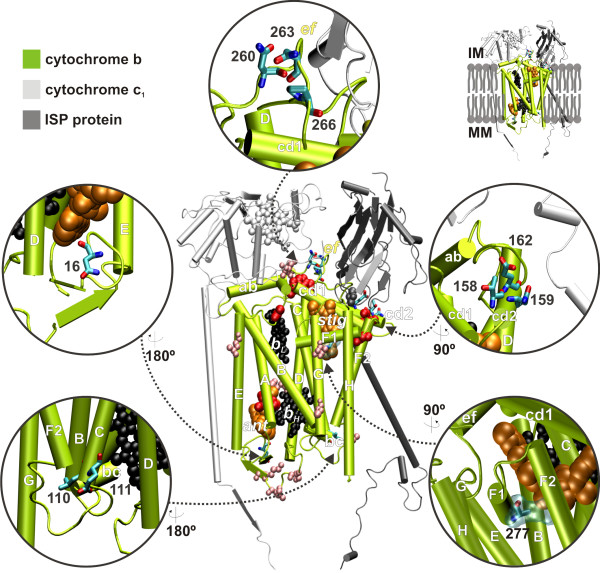
Three-dimensional representation of relevant variable amino acids in mammalian cytochrome b. Illustrative representation of some of the amino acid variable sites (see Figure 10) located in relevant functional spots of the bovine CytB structure (pdb code: 1PPJ [66]). The prosthetic groups in CytB are represented in black, and the Qi and QP bound inhibitors in orange (ant: antimycin; stig: stigmatellin). Mutations in sites shown in red have been related to exercise intolerance in humans (see Table 1). Mutations in sites shown in pink are under strong positive selection according to the TreeSAAP analysis (over 5 positively selected properties). In site 277, the alanine present in the bovine structure is shown as ball and stick and the van der Waals surface for the arginine found in dugong is also depicted. MM: mitochondria matrix; IM: intermembrane space.